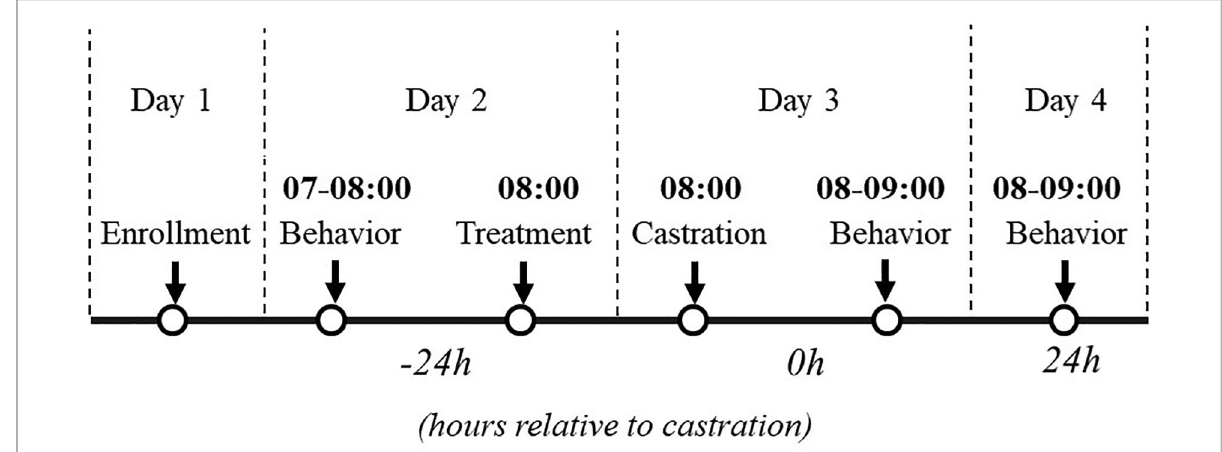
FIGURE 1 Study design and data collection. Treatment: physiological saline or transdermal fl unixin. Castration: surgical castration or sham castration. Behavior: video recording continuously for one